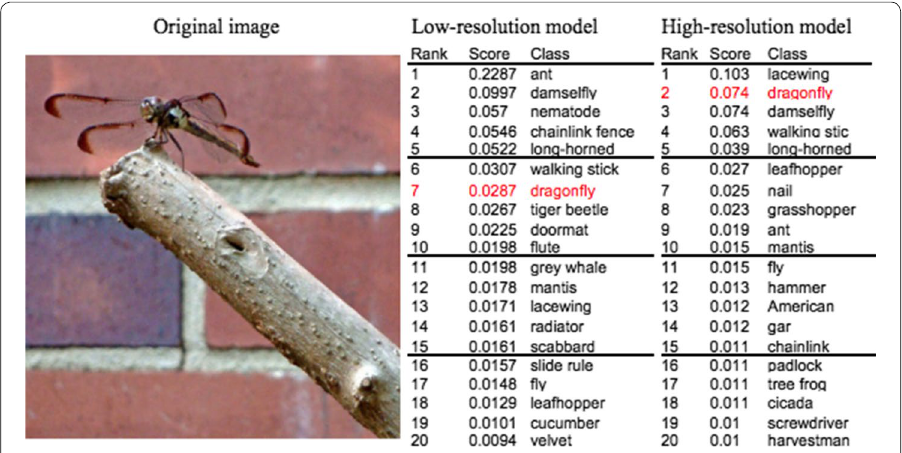
Fig. 33 Classifications of the Image to the right by different resolution models trained by Wu et al.